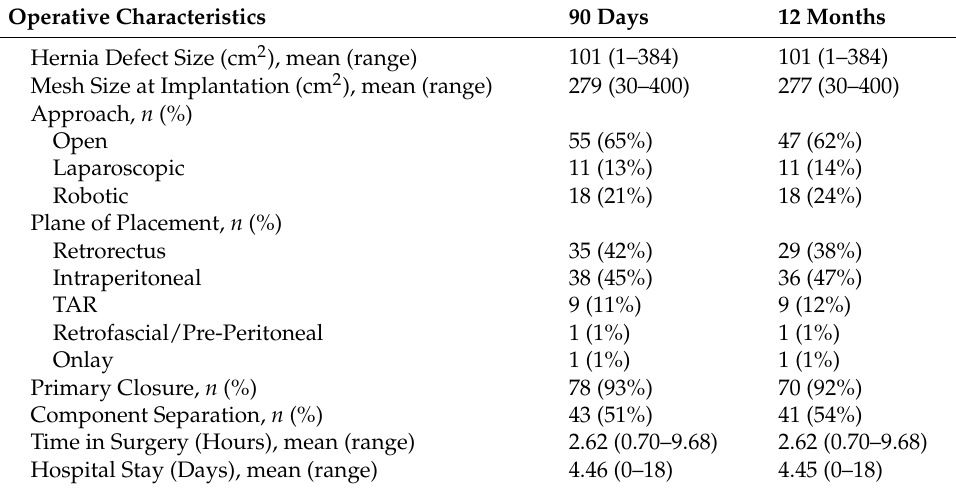
Table 2. Operative Characteristics.